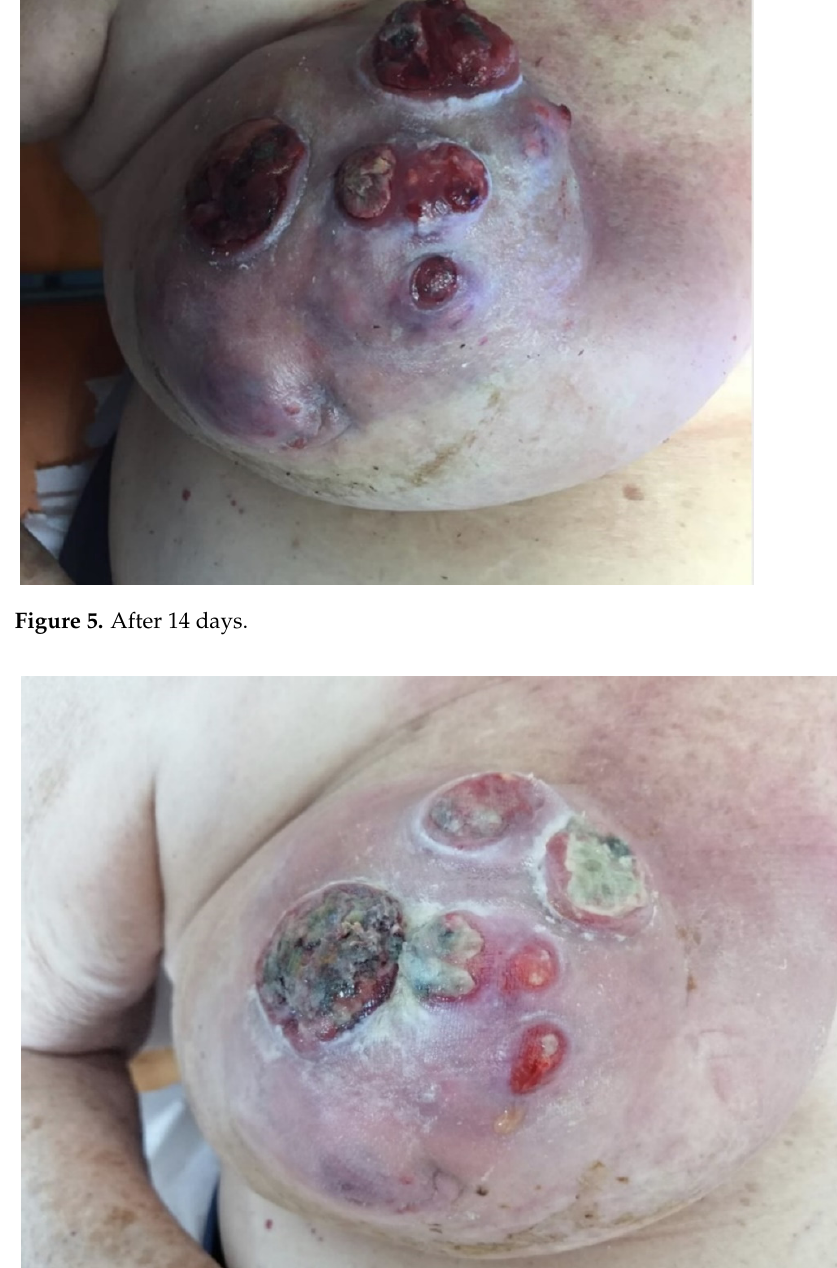
Figure 6. After 20 days.